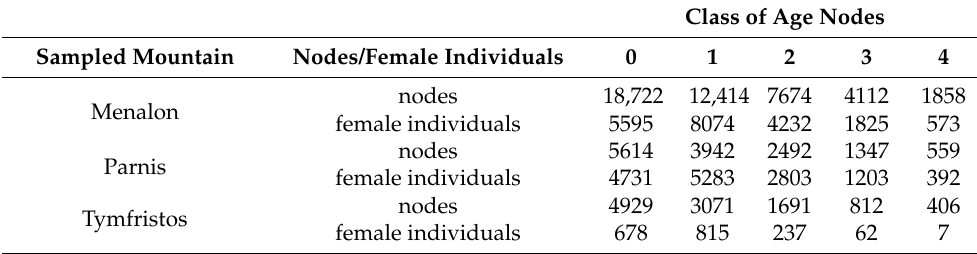
During our study, the infestation [I (%) ] of P. hellenicus reached very high values,